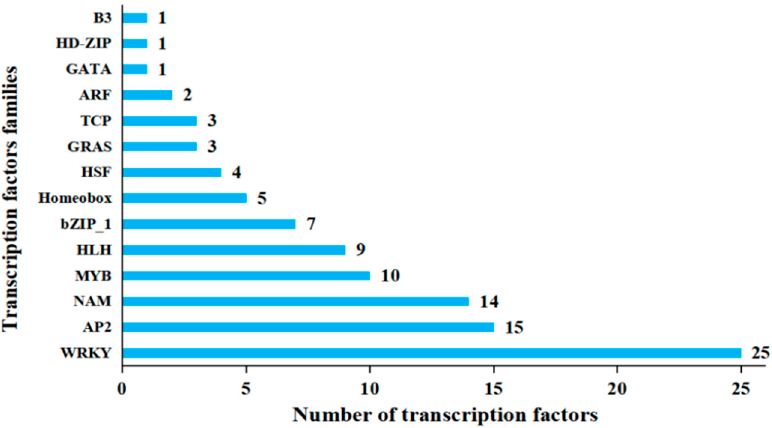
Figure 2. Transcription factors differentially expressed under mechanical wounding in A. sinensis